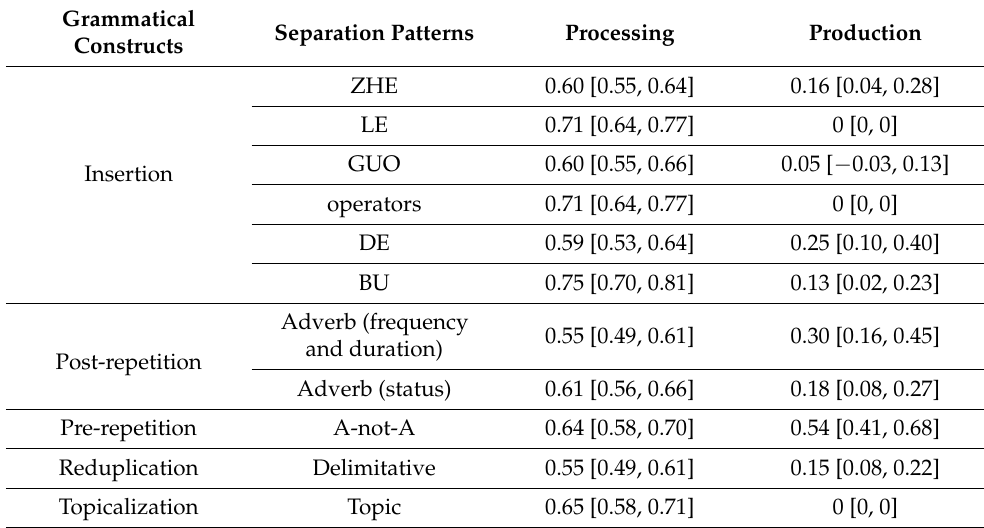
Table 2. Summary of the mean accuracies with 95% confidence intervals in the brackets of processing and producing verb separation by separation